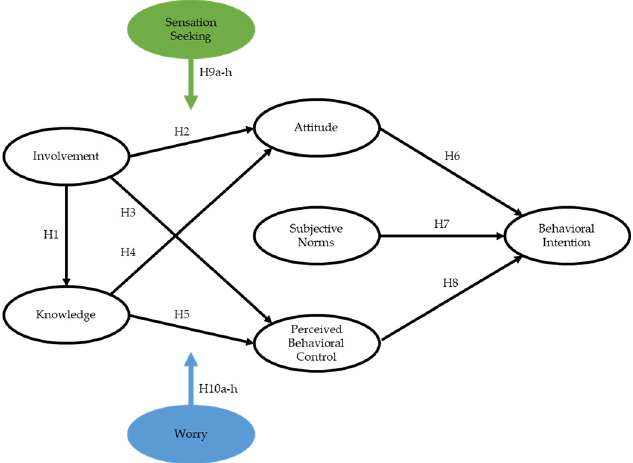
Figure 1. Proposed conceptual model.